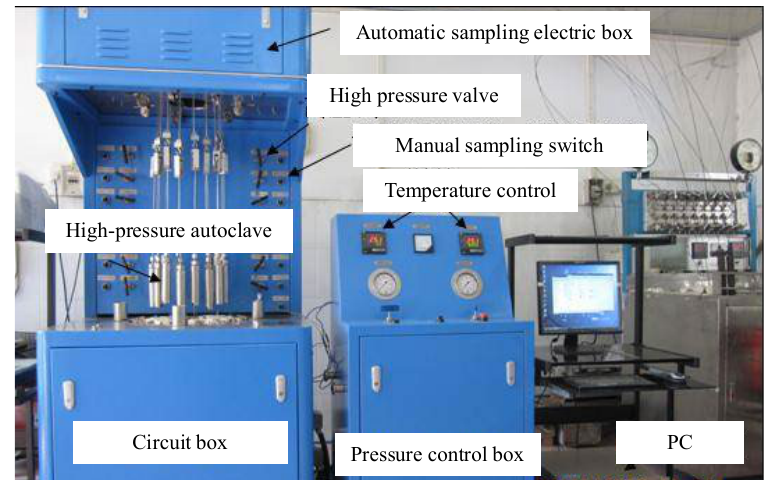
Figure 2. Thermal simulation experimental setup of the closed system.